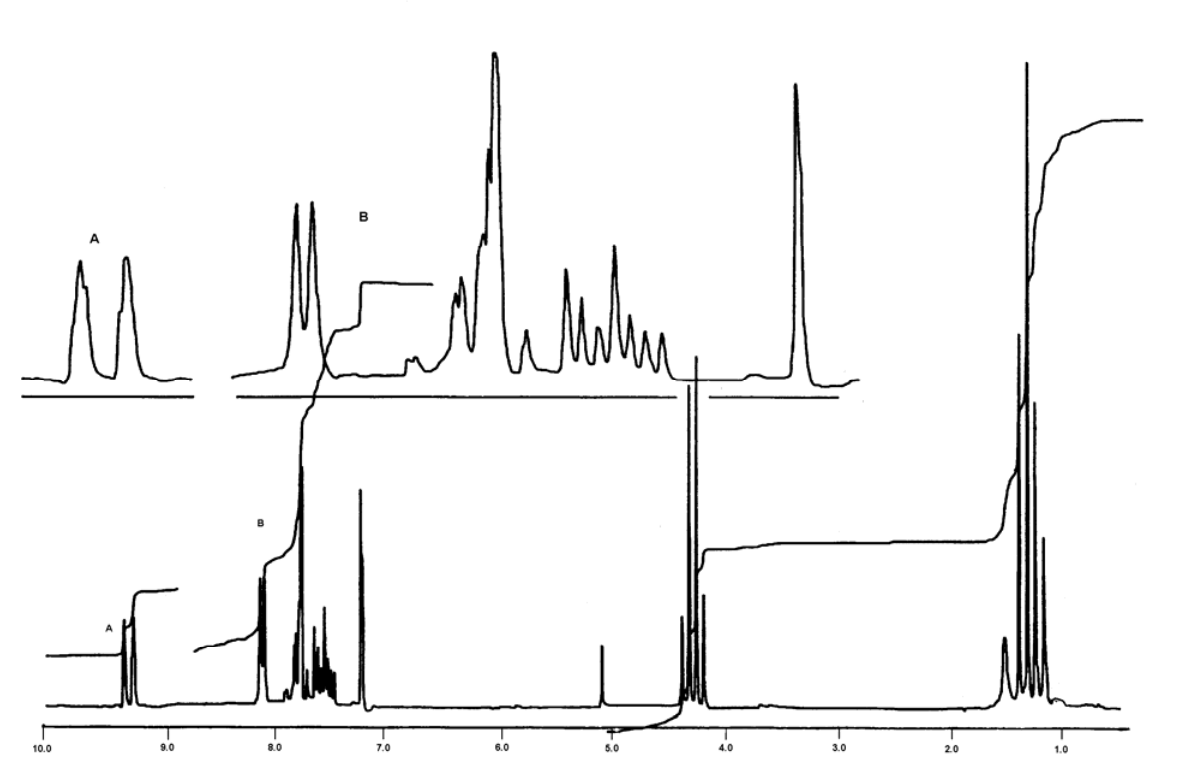
Figure 4. NMR spectrum of compound 1 (zones A and B also shown in expanded